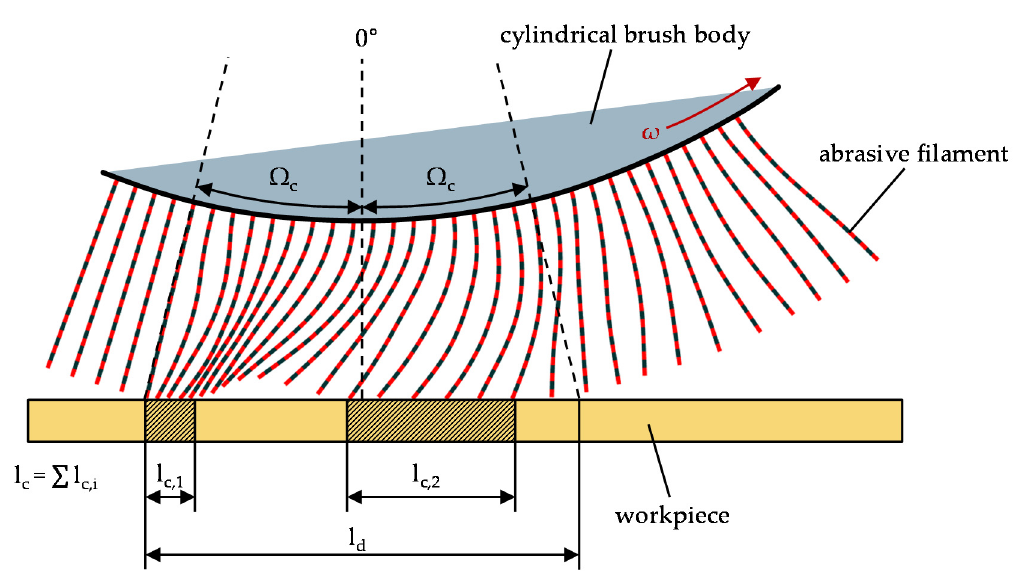
Figure 2. Simulation of the deflection of a single abrasive filament during workpiece contact.